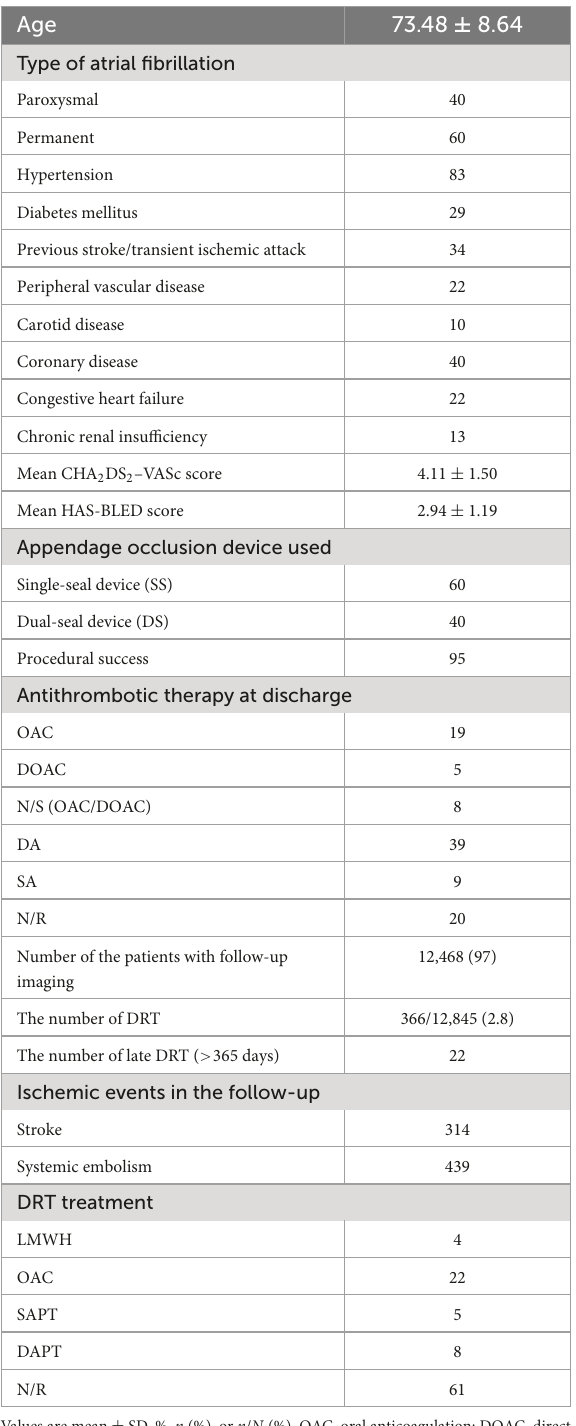
TABLE 2 Baseline characteristics of the studied patients ( N =